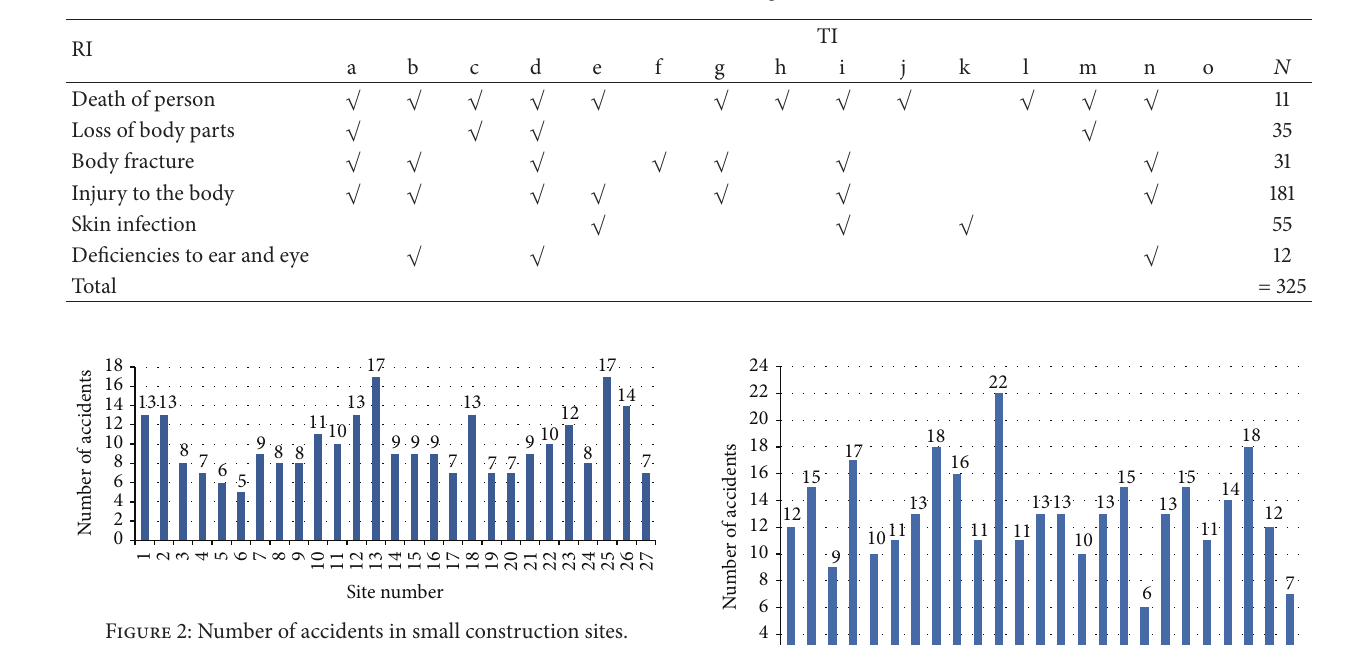
Table 5: Overall accident details in large construction sites.